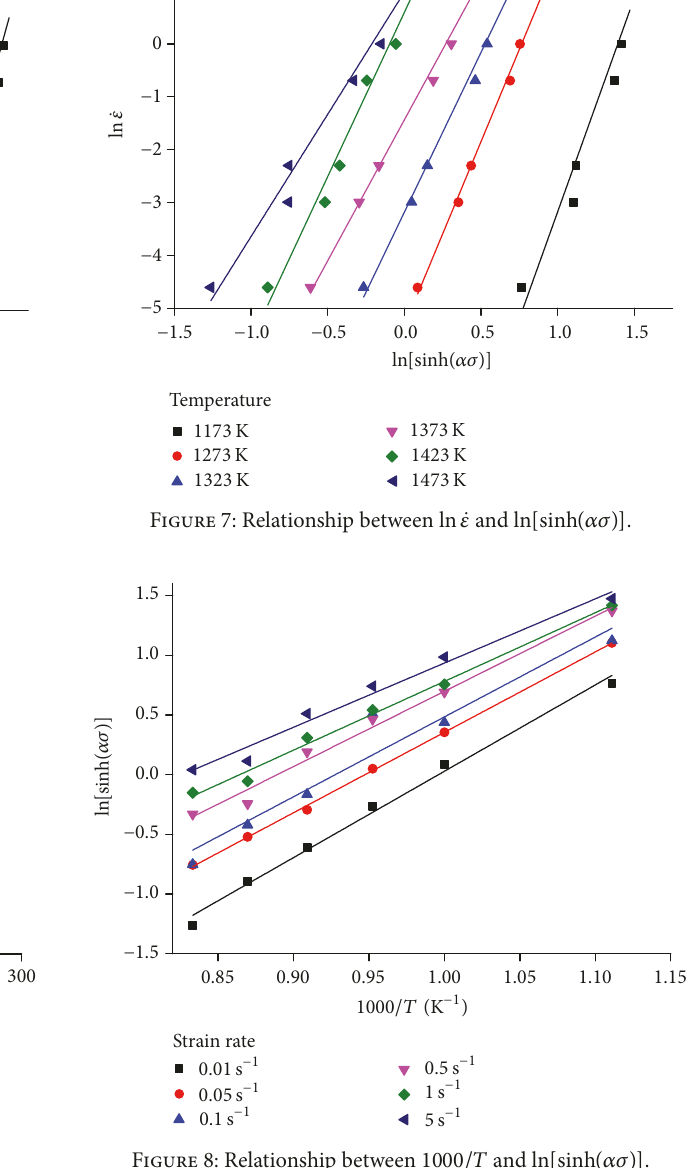
Figure 6: Relationship between 𝜎 and ln ̇𝜀 .